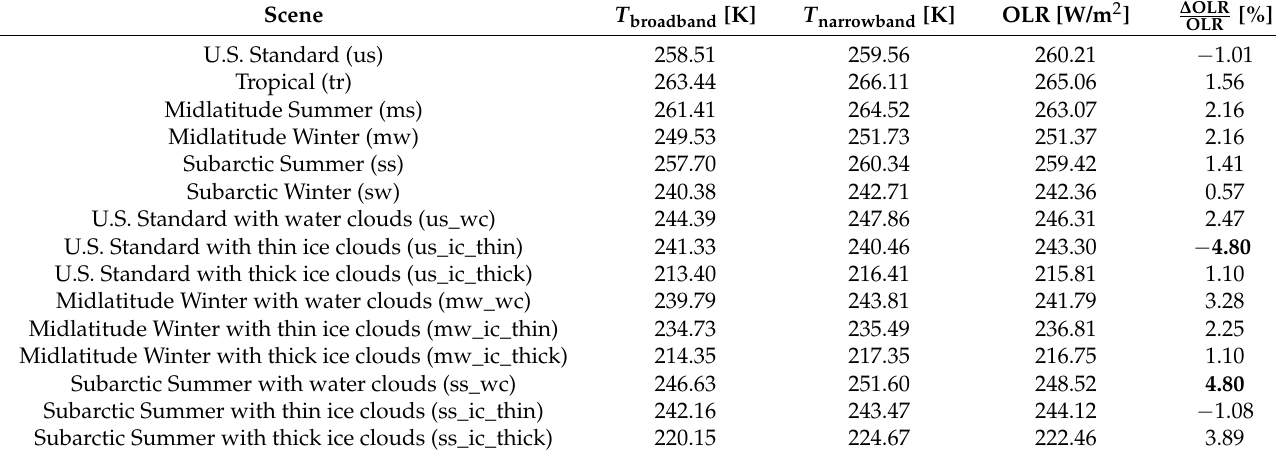
Table 4. 15 scenes simulated in libRadtran, listed in Table 3, with their broadband and narrowband temperatures, estimates of the OLR and relative errors on these